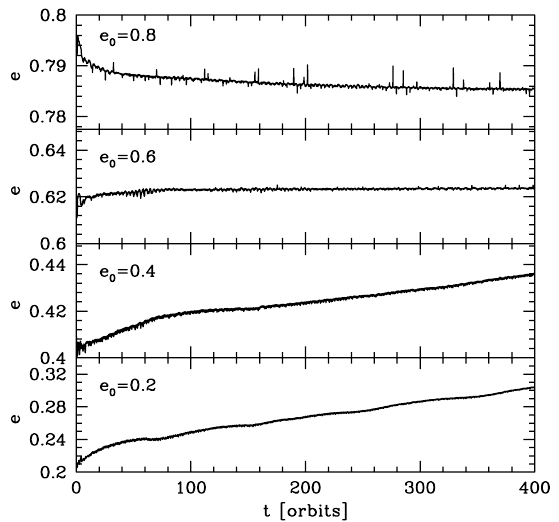
Figure 3. Eccentricity evolution of binaries starting with di ff erent eccentricities. This quantity tends to a value in the range e ∼ 0.6– 0.8. Figure from Roedig et al (2011).